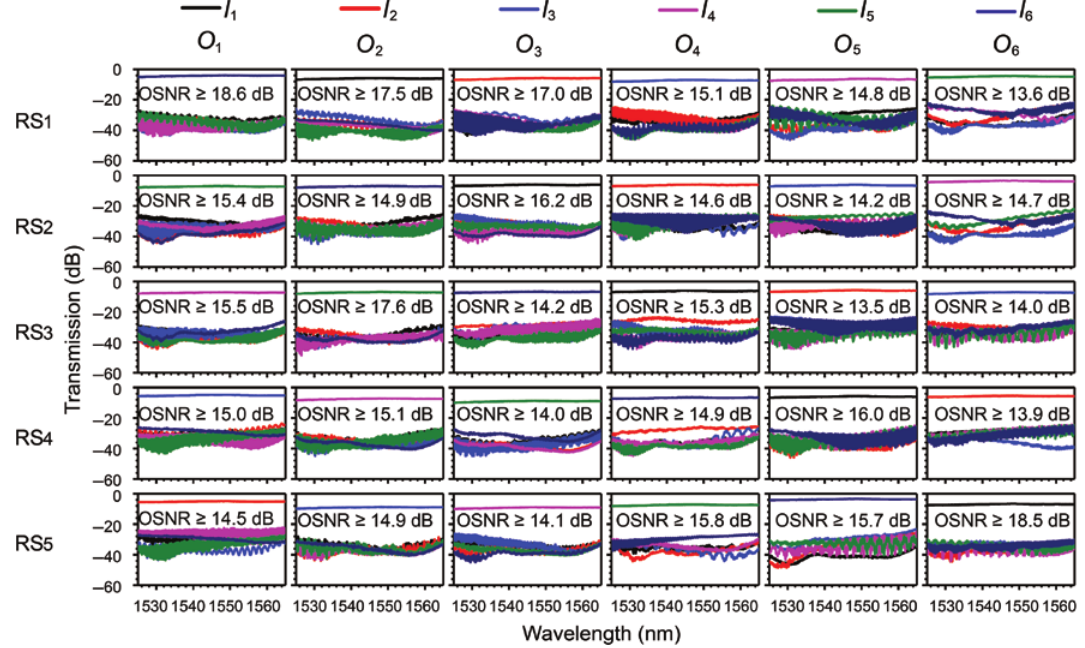
Figure 4: Static spectral responses of the optical switch in the selected five routing states (OSNR, optical signal-to-noise ratio; RS, routing